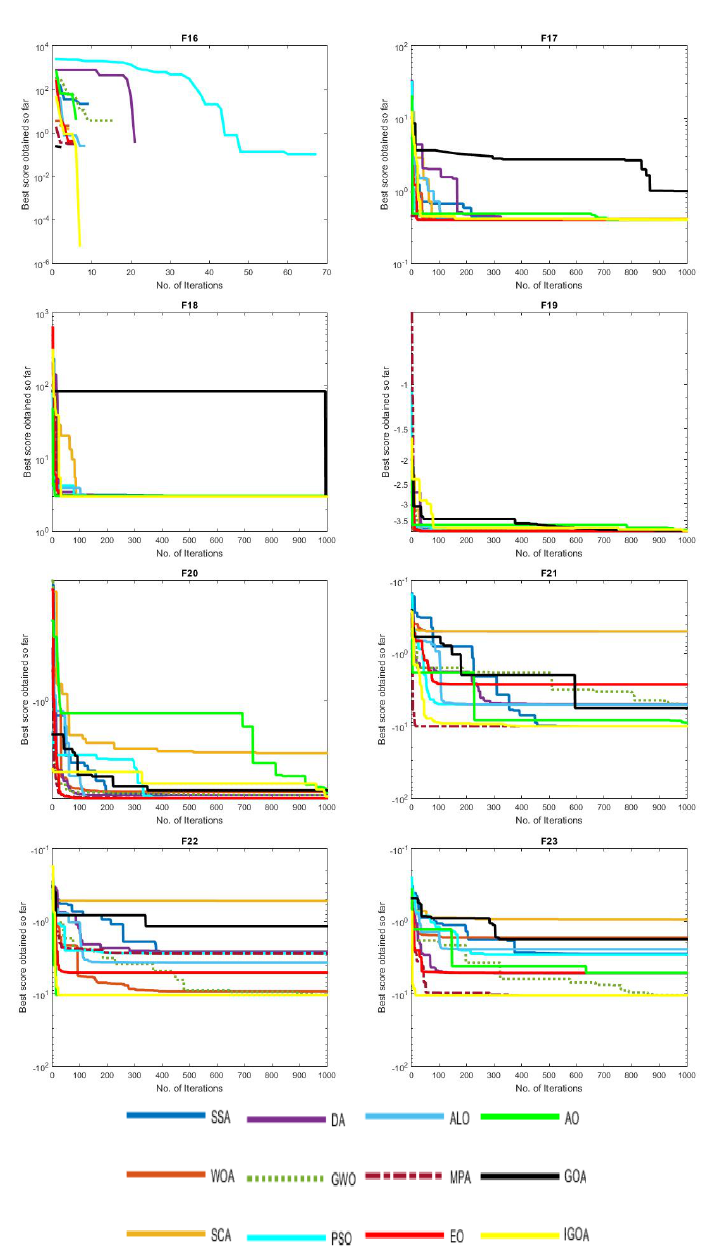
Figure 7. Convergence behaviors of the comparative algorithms on classical test functions